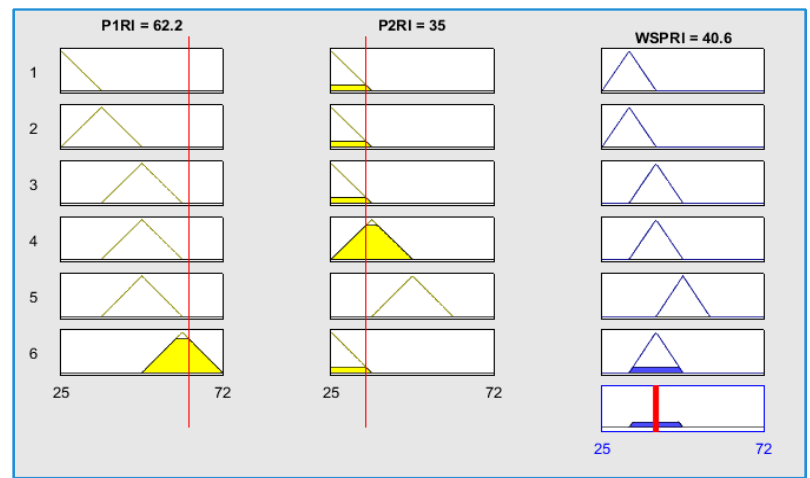
Figure 15. Example of fuzzy rules used in B_FIS .